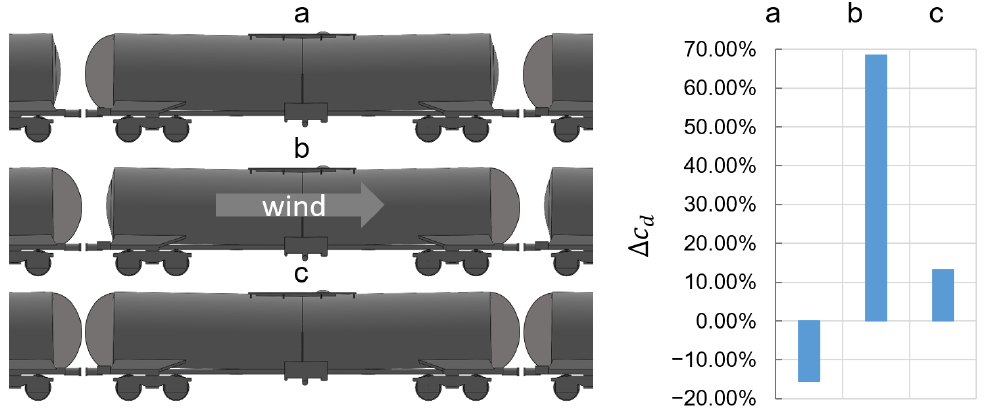
Figure 6. Influence of face radius; ( left ) images: a applied to upstream face, b applied to downstream face; c applied to both faces; ( right ) graph: obtained drag